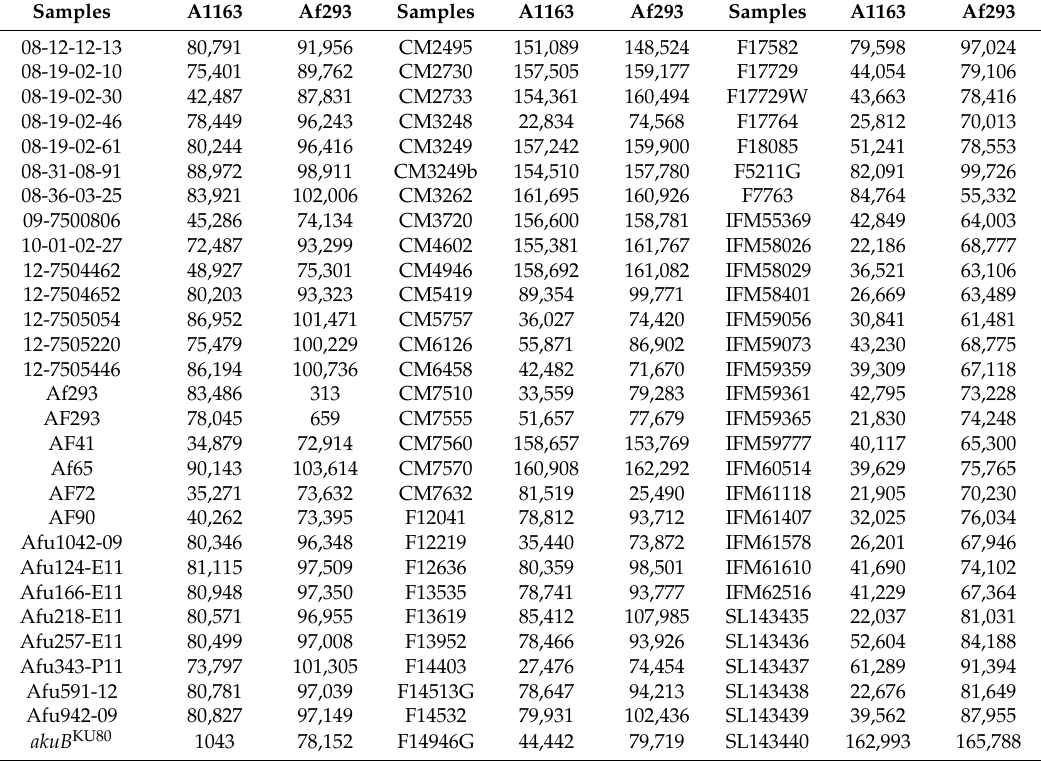
Table 4. Single nucleotide variant differences compared to both reference genomes. Variants of each A. fumigatus genome included in this